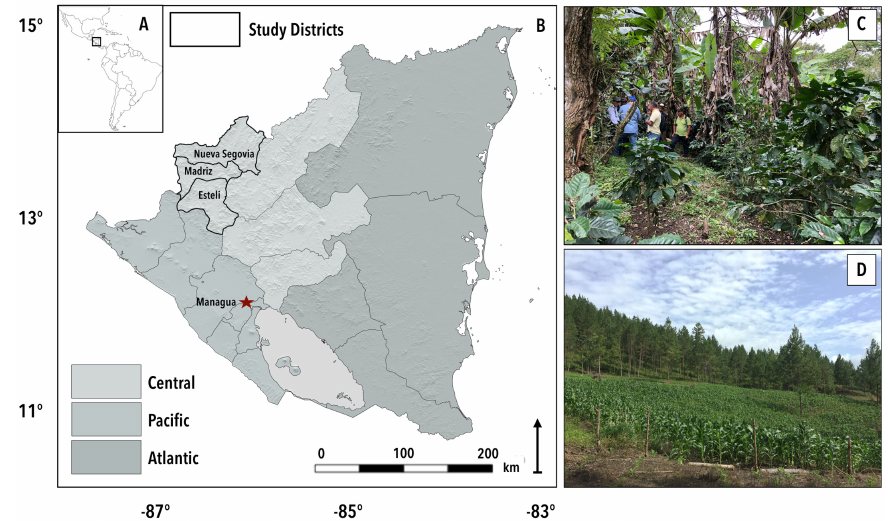
Figure 2. Overview of the study area in northwest Nicaragua. ( A ) Nicaragua in a Central American regional context. ( B ) Primary climate zones (grey) with study areas noted using thick district boundary lines. The specific study districts included Esteli, Madriz, and Nueva Segovia. ( C ) Field photo of discussion about participatory mapping approaches in a structurally complex shade-coffee plot. ( D ) Field photo of “milpa” croplands adjacent to pine stands.